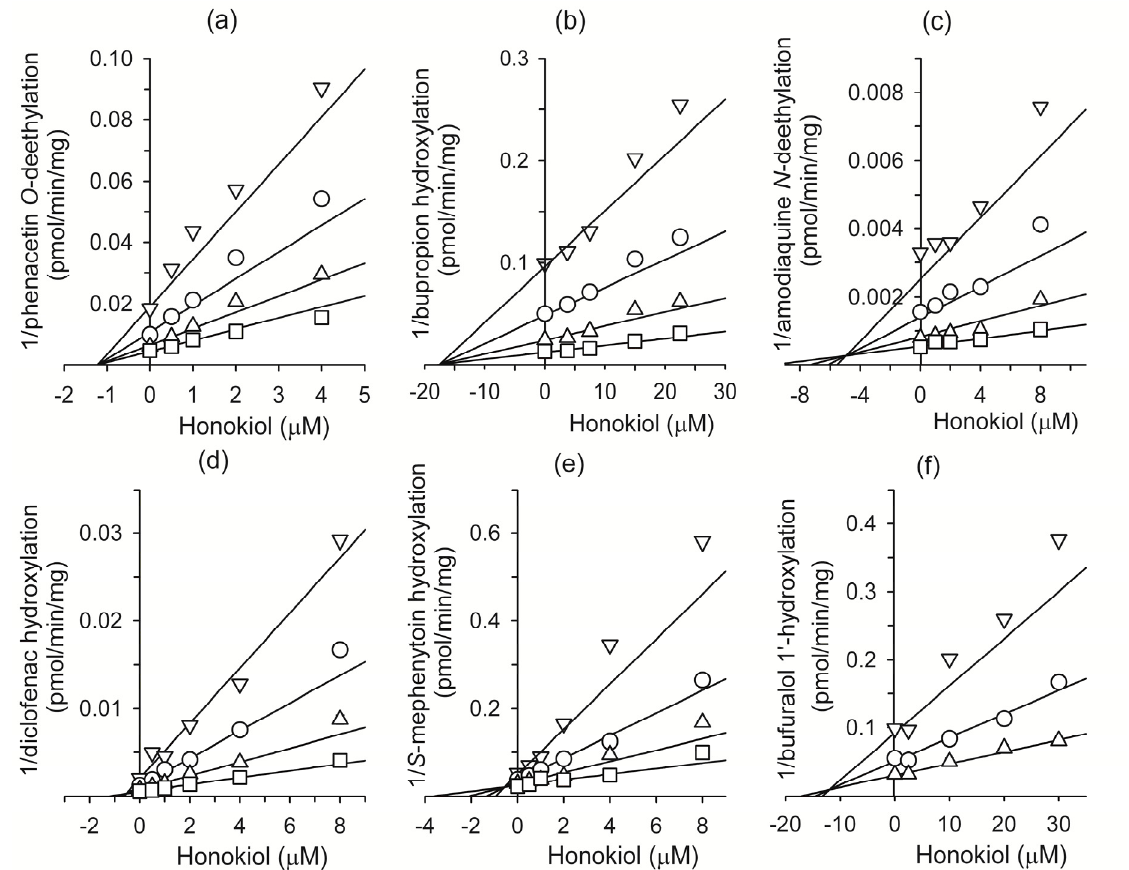
Figure 2. Representative Dixon plots for the inhibitory effects of honokiol on ( a ) CYP1A2-catalyzed phenacetin O -deethylation, ( b ) CYP2B6-catalyzed bupropion hydroxylation, ( c ) CYP2C8-catalyd amodiaquine N -deethylation, ( d ) CYP2C9-catalyzed diclofenac 4-hydroxylation, ( e ) CYP2C19-catalyzed [ S ]-mephenytoin 4-hydroxylation, and ( f ) CYP2D6-catalyzed bufuralol 1'-hydroxylation in pooled human liver microsomes (H161). Each symbol represents the substrate concentration: ( a ) phenacetin 10 μ M ( ▽